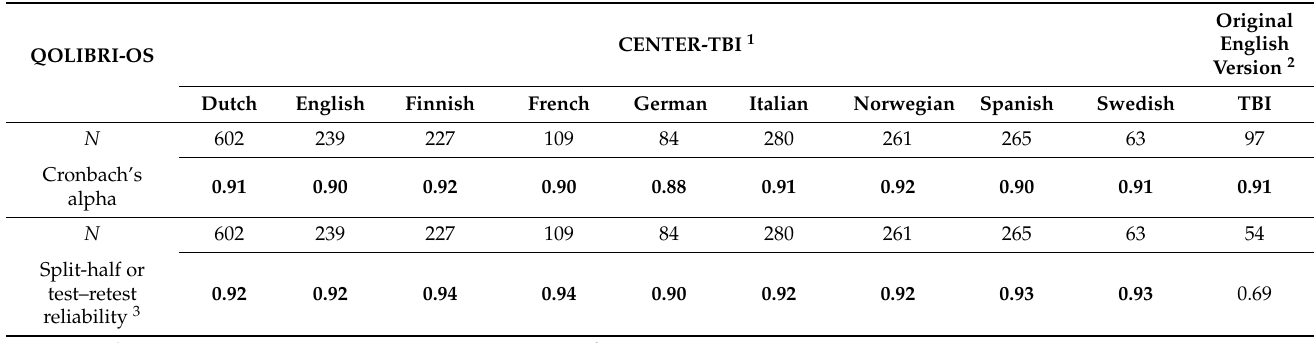
Table 6. Comparison of the CENTER-TBI results with the values from the original English validation study in the field of